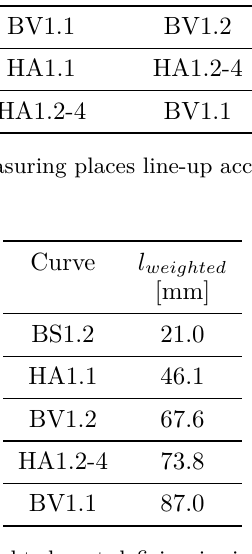
respectively) is calculated for each measuring place (curve) as shown in Table 2, the rank of the values in comparison with the Tab. 1 matches the wavelength range 100-300 mm.